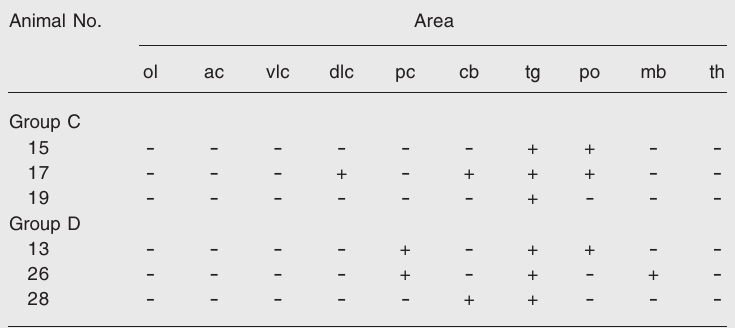
Table 2. Detection of bovine herpesvirus 1 DNA by PCR in brain sections of rabbits 60 days after intranasal virus inoculation (group C) and 60 days after dexamethasone- induced virus reactivation (group D). Animal No.